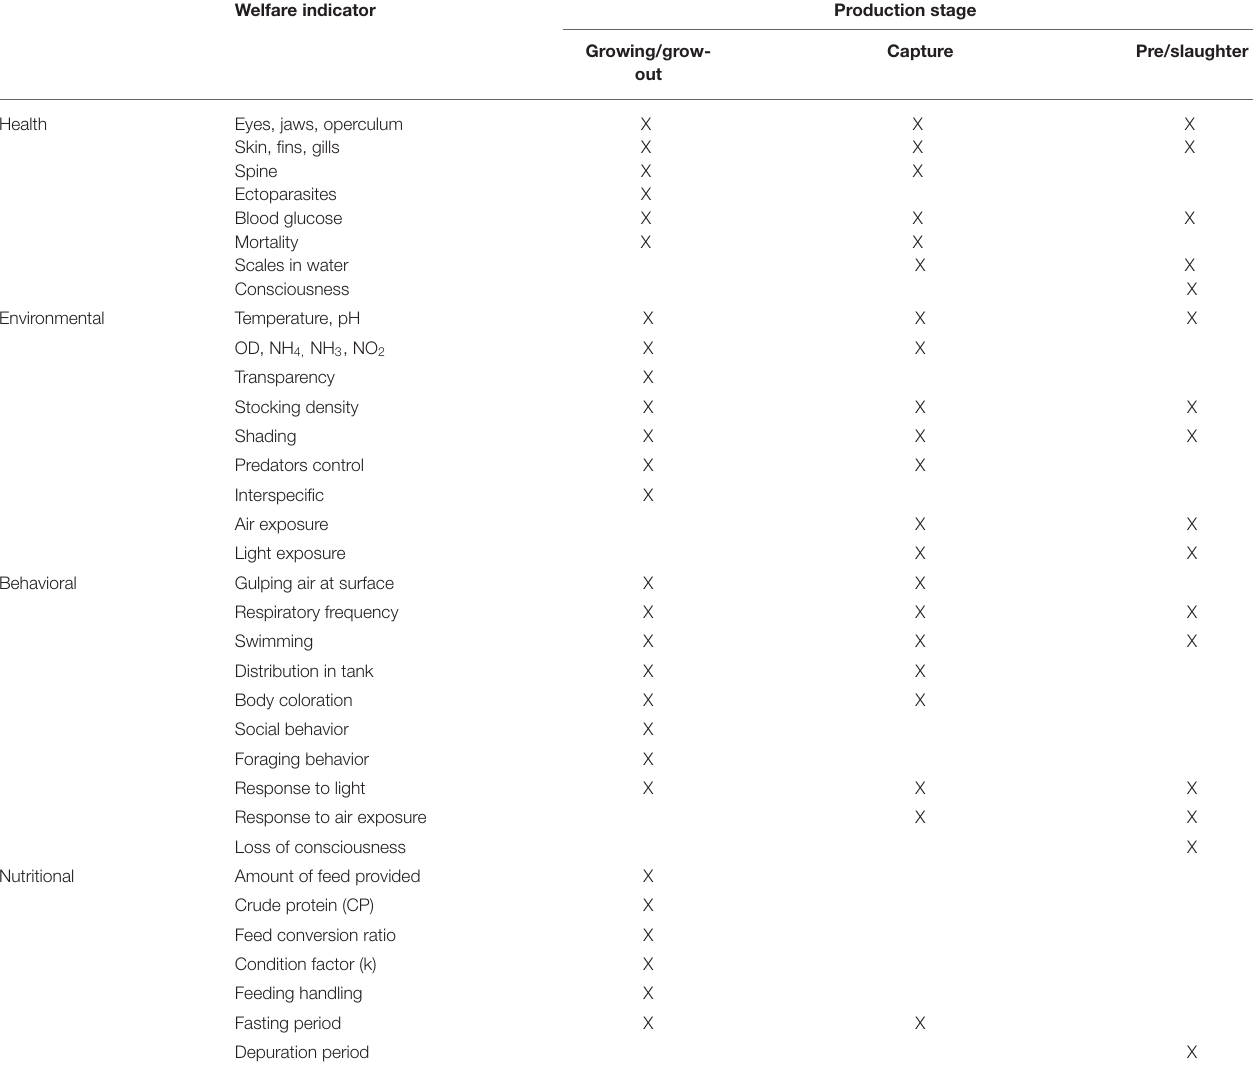
TABLE 1 | Health, environmental, behavioral, and nutrition indicators for the assessment of farmed tilapia welfare, based on Stien et al. (31). Welfare